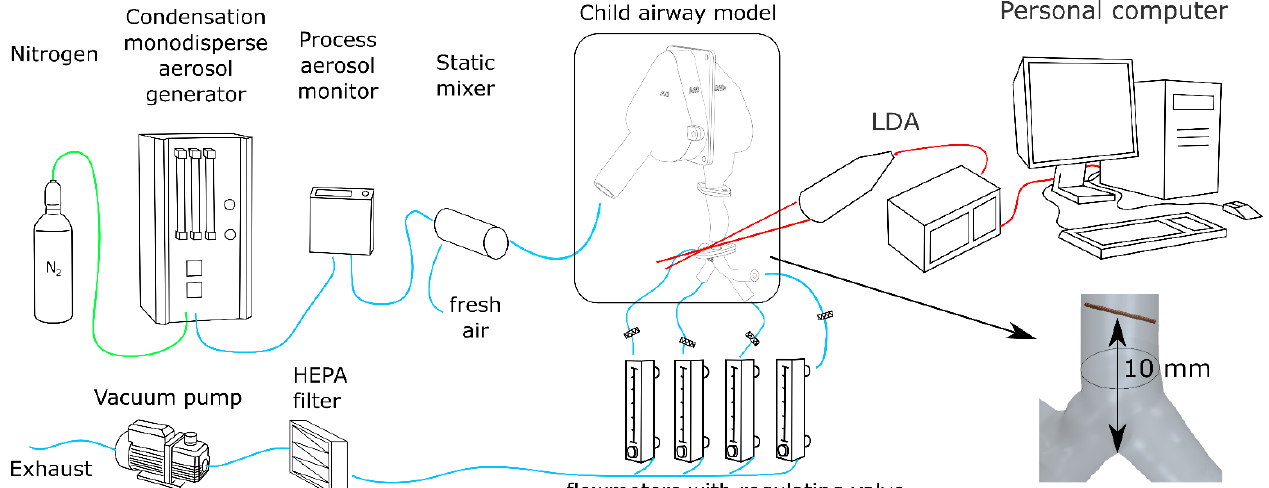
Fig. 2. Experimental setup of the LDA measurement